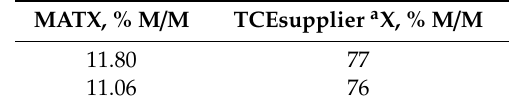
Table 20. Conversion (X) evaluated through the Micro Activity Test and TCE of the Equilibrium Catalyst (ECat), (RESIDCAT ® R 137).